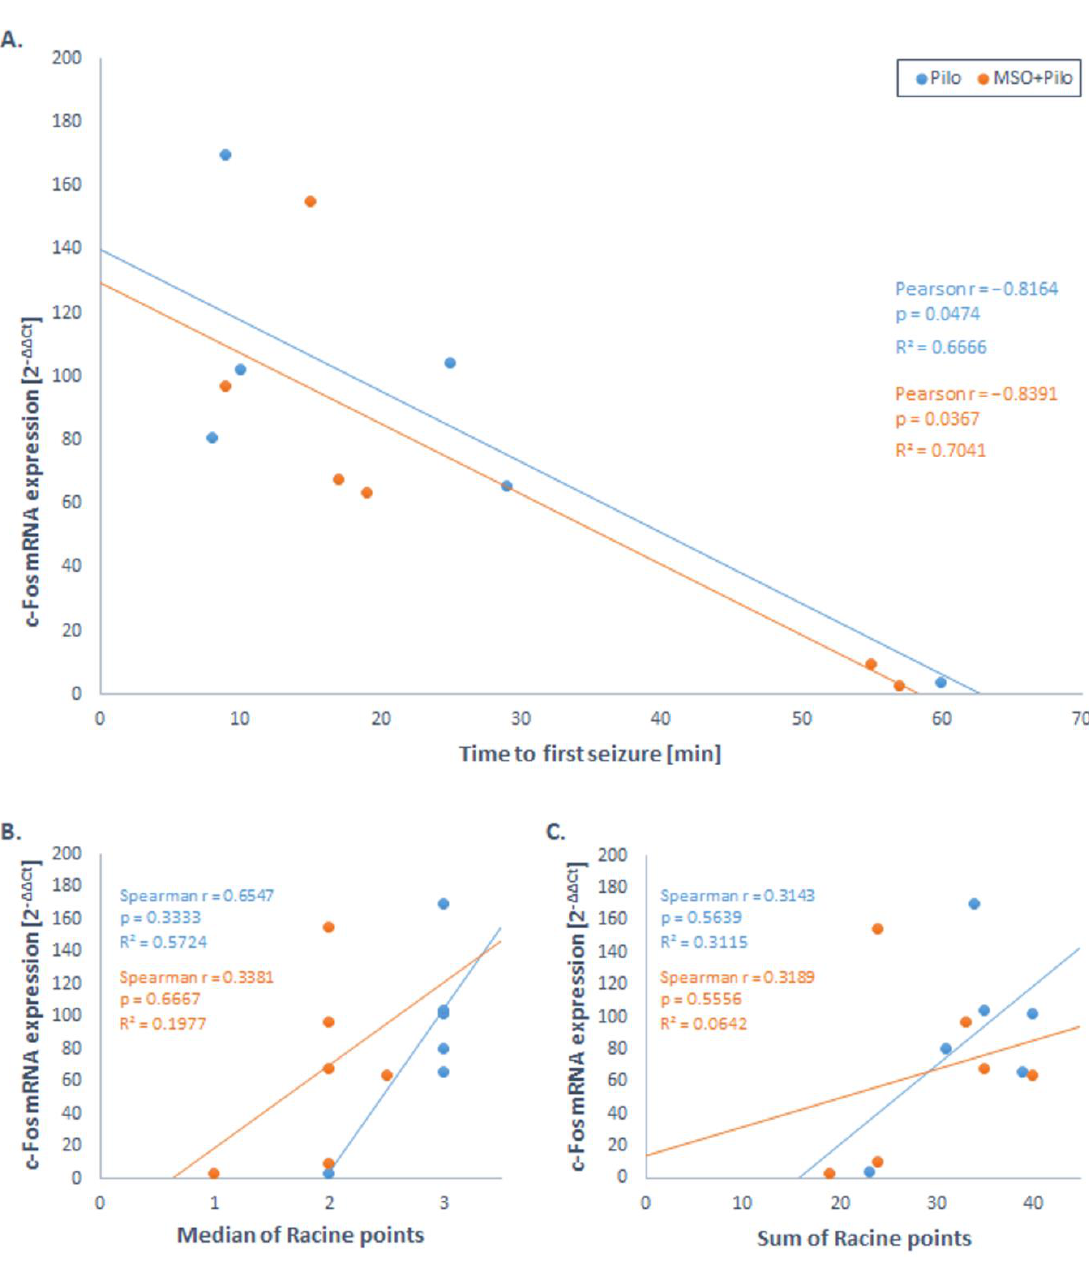
Figure 1. C-Fos mRNA expression in the hippocampus vs. time to the onset of the first generalized seizure ( A ) and the seizure intensity: median of the Racine points ( B ) and sum of the Racine points ( C ). Rats received one dose of glutamine synthetase inhibitor MSO (MSO + Pilo group, N = 6) or an equal volume of saline (Pilo group, N = 6) 2.5 h before the convulsive agent—pilocarpine. ( A ) Point 0 is the time of pilocarpine application. Assessment of the Racine score was made every 5 min up to 60 min after pilocarpine, when the animals were decapitated, and the brain tissue was dissected. A correlation coefficient was considered statistically significant at the two-tailed p -value <0.05. For a more detailed description of the model used, see Reference [68]. The total RNA was isolated from the hippocampus using a TRI reagent (Sigma). The extracted RNA was reverse-transcribed using the High-Capacity cDNA Reverse Transcription Kit (Applied Biosystems, Foster City, CA, USA). The mRNA expression was determined by Taqman Gene Expression Assays (Applied Biosystems) using 1 µ L of cDNA in a reaction of 10 µ L. The assay IDs were Rn02396759_m1 for rat c-Fos and Rn00667869_m1 for β -actin. The fold change in the gene expression was determined by the 2 − ∆∆ Ct method